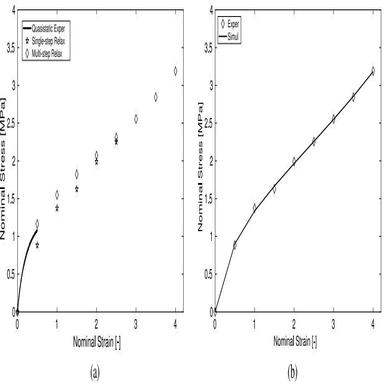
Viscous parameters identification with a loading–unloading cyclic data for 400% strain at a strain rate of 0.384 /s with linear relaxation times: (a) Model fitting with one Yeoh and four Neo–Hooke Maxwell elements with ten viscous parameters (total thirteen parameters; three elastic and ten viscous), (b) model validation with one Yeoh and four Neo–Hooke Maxwell elements (thirteen parameters in total).